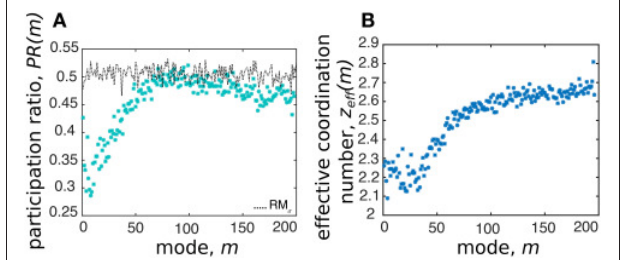
FIGURE 14 | While consistent with our general findings, not all measures of structure explain collective motion. (A) The participation ratio PR( m ) initially decreases as a function of mode number, but after m the random case (dotted line). (B) The effective coordination number z eff ( m ) shows the lowest modes are